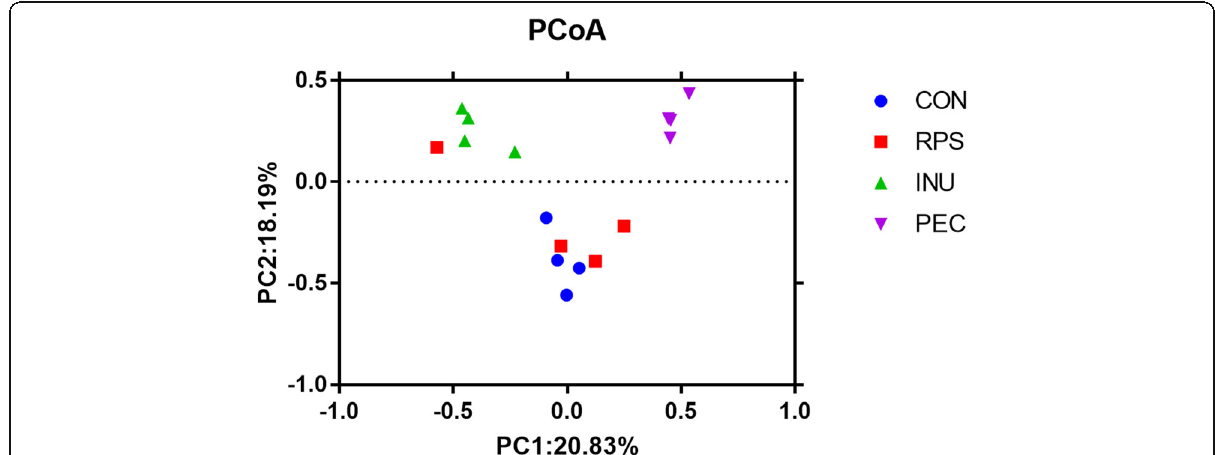
Fig. 2 Bray-Curtis PCoA plot of colonic bacteria of the abundant genes. The percentages in the axis labels represent the percentages of variation explained by the principal components. A closer proximity of dots indicates higher similarity. CON, control diet; RPS, raw potato starch-enriched diet; INU, inulin-enriched diet; PEC, pectin-enriched